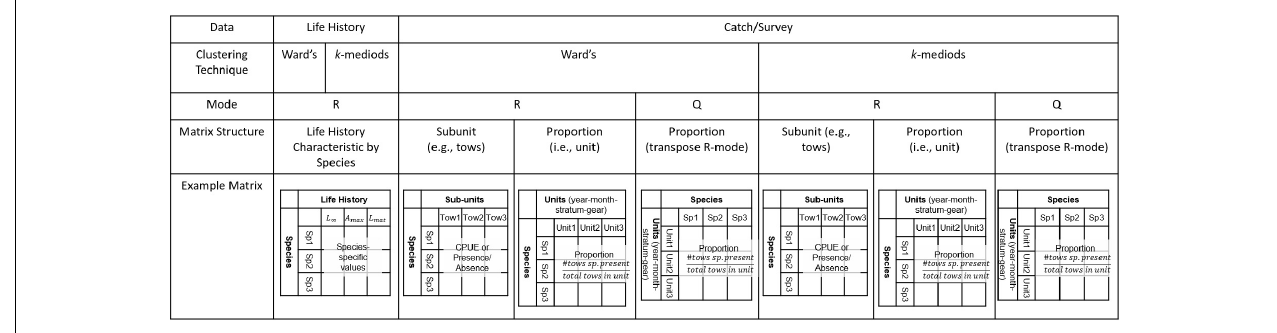
FIGURE 2 | Design of the model analyses identifying data, clustering technique and input matrix structure for each aspect of the cluster